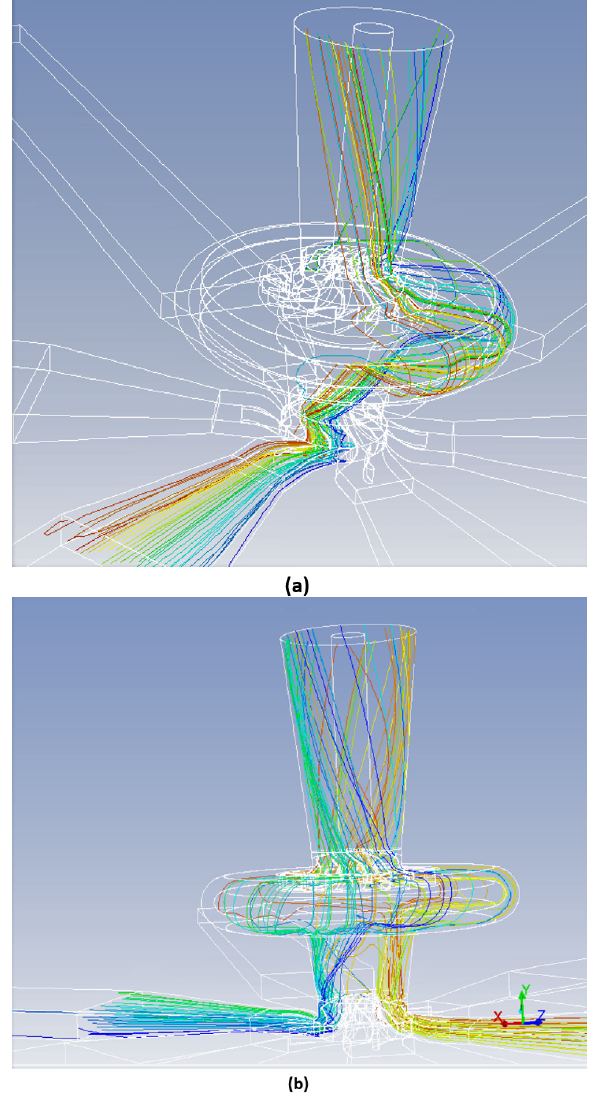
Figure 14. The pathlines from the: ( a ) single exhaust pipe, ( b ) two opposite exhaust pipes. The flow path from a single exhaust pipe was very complex and covered one quarter of the inter-stage pipe